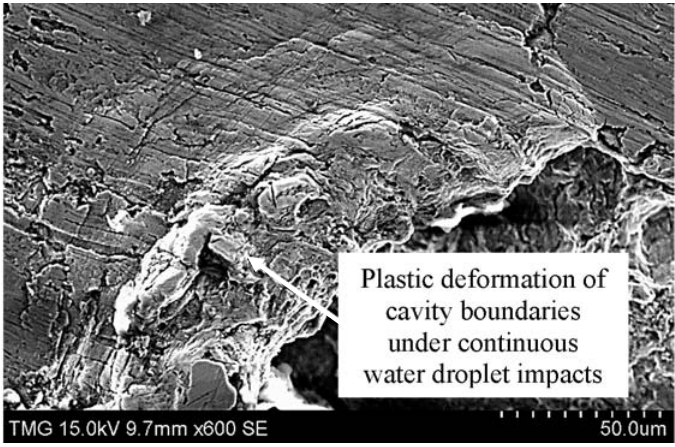
Figure 21. ( a ) and ( b ) SEM micrographs show ductile slip bands on the surface of the non-treated Ti64 specimen in the initial stages of LIE test.